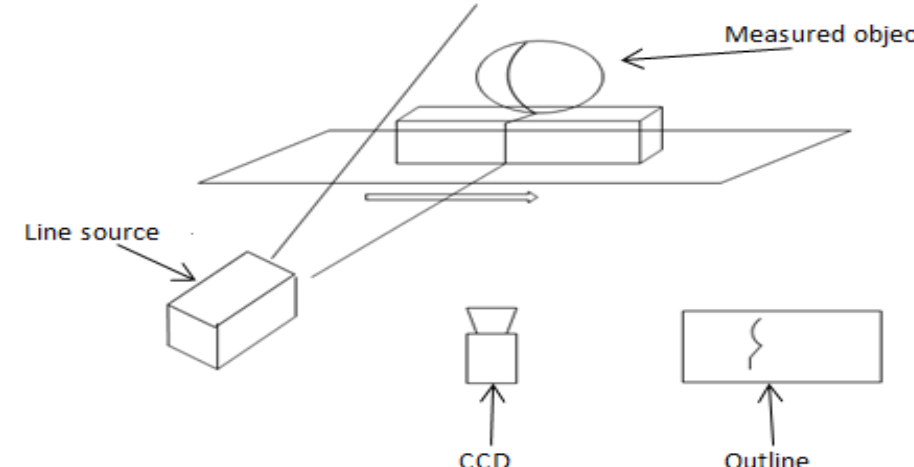
Figure 4. The Principle of Structured Light 3D Detection.